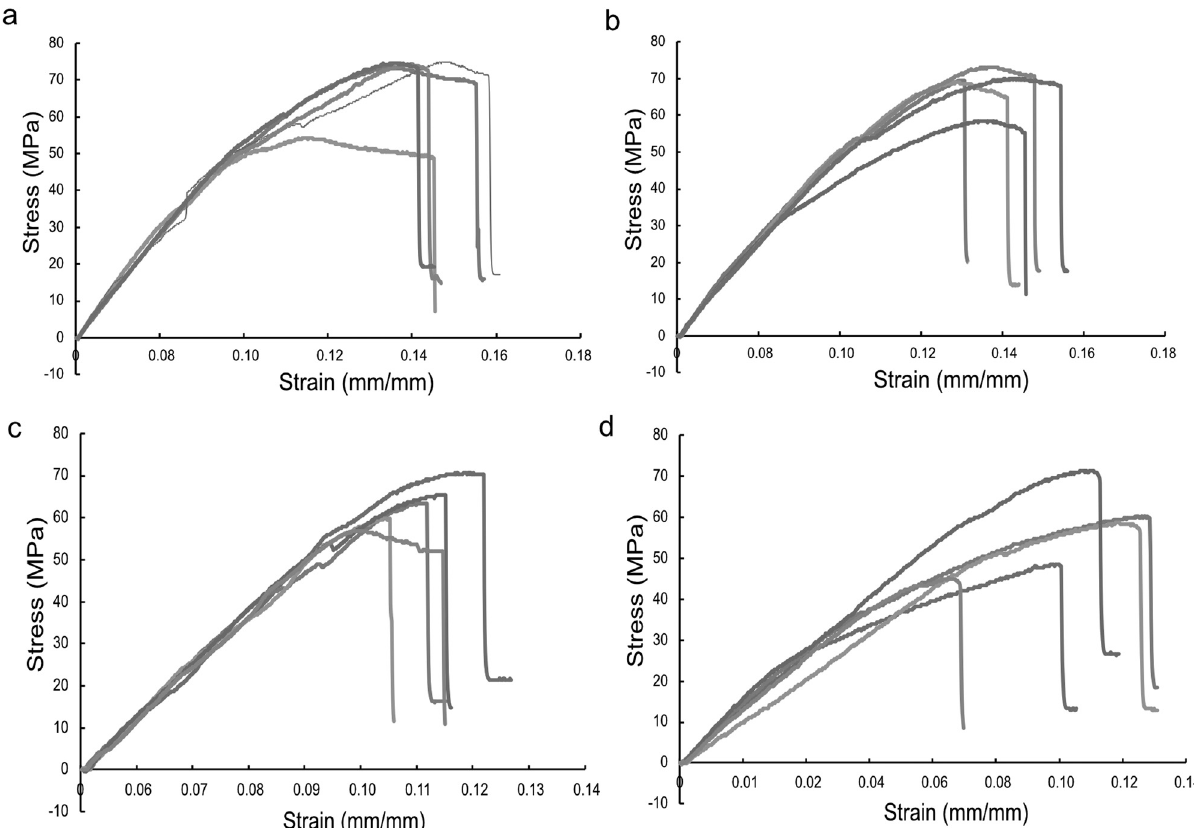
Figure 2: Stress – strain curve for: ( a ) neat PLA, ( b ) 1% cellulose composite, ( c ) 3% cellulose composite, and ( d ) 5% cellulose composite. Depicted are the individual curves of fi ve replicates of each sample.